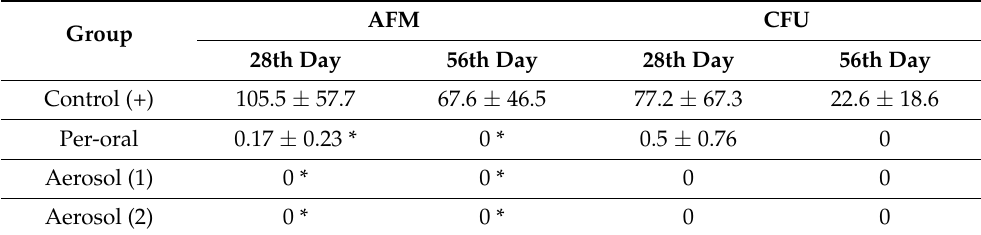
Table 3. Average number of AFM per 100 visual fields and CFU in the plates after the inoculation of the organs of experimental animals, *— p < 0.05 with respect to Control (+)